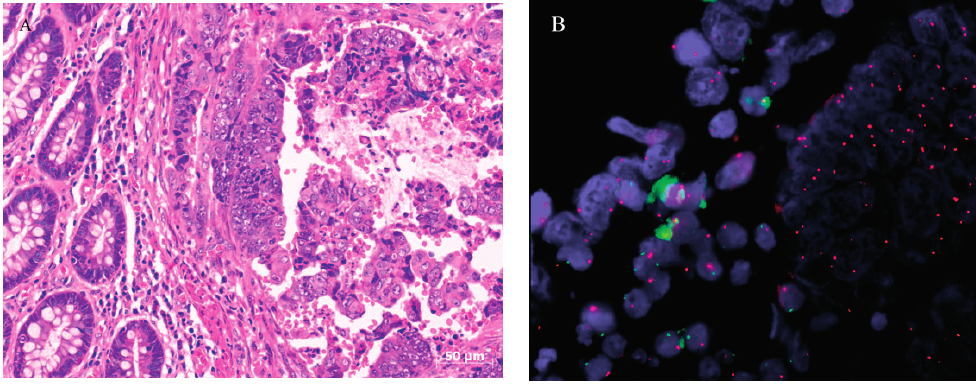
Figure 3. Morphology of a male colorectal cancer with feminization. ( A ) A hematoxylin and eosin stained histological section showing tumor on the right-hand side and normal colonic mucosa on the left; ( B ) Fluorescence in-situ hybridization of tumor cells (right-hand side) show multiple red centromeric enumeration probe (CEP) X signals indicating X chromosome gains and absence of green CEP Y signals indicating Y chromosome losses, while both red and green signals are present in non-neoplastic interstitial cells (left-hand side).